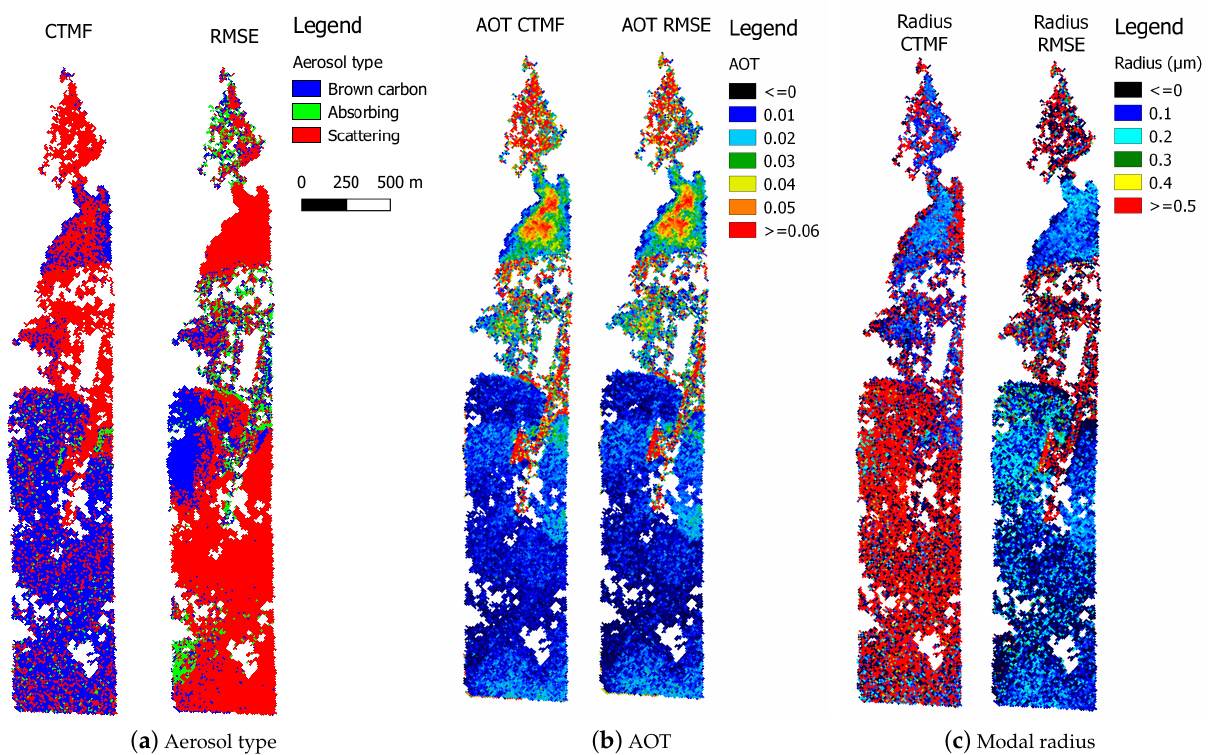
Figure 6. Retrieved plume aerosol parameters: ( a ) model, ( b ) AOT, and ( c ) modal radius, using the CTMF compared with the RMSE.